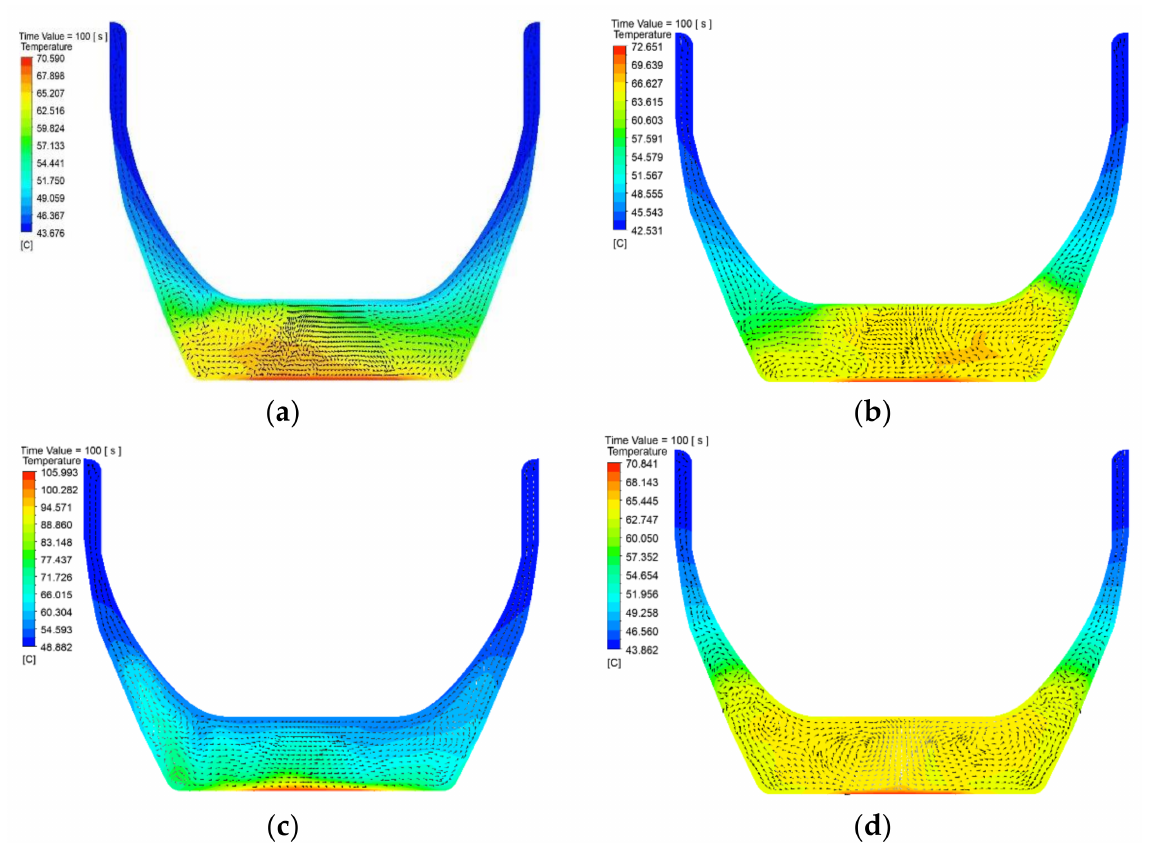
Figure 17. Temperature and the flow vector, Model 1. ( a ) VF = 10%, Q = 10 W. ( b ) VF = 30%, Q = 10 W. ( c ) VF = 30%, Q = 20 W. ( d ) VF = 50%, Q = 10